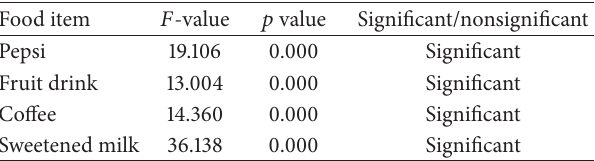
Table 5: Comparison of mean salivary flow rate after beverage consumption at different intervals of time (one-way